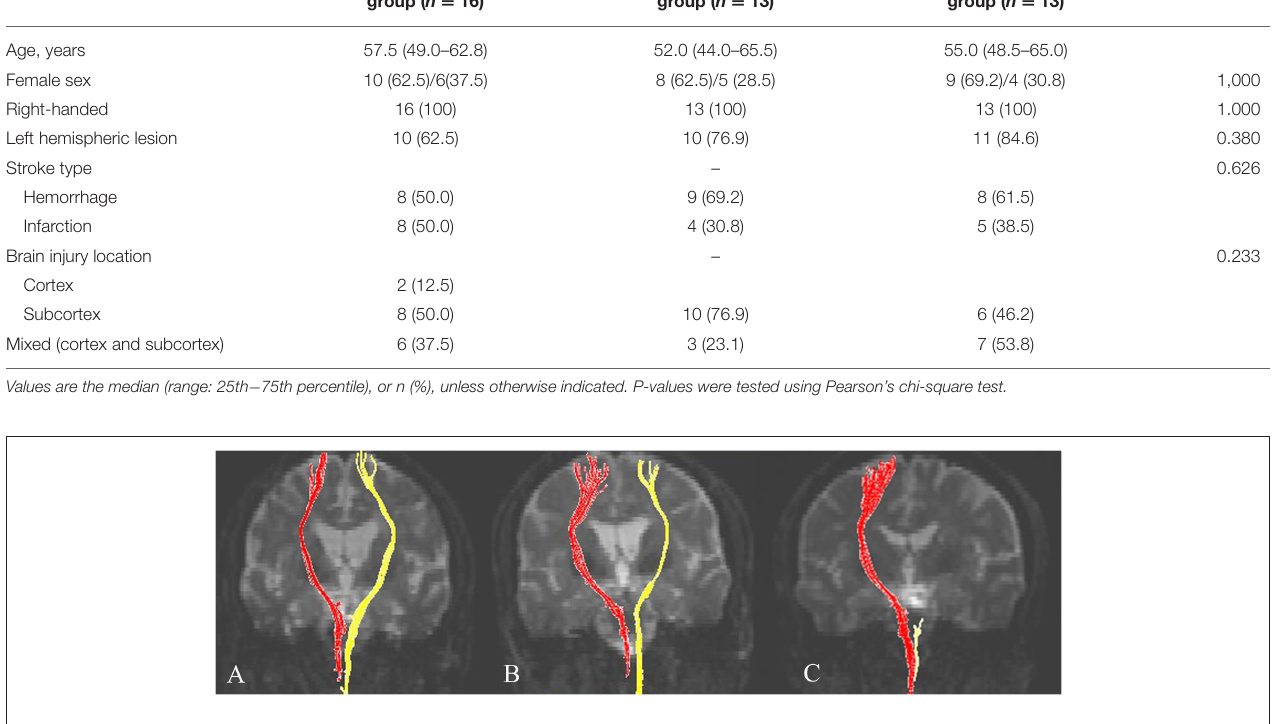
FIGURE 2 | Representative diffusion tensor tractography images of the corticospinal tract in typical subjects from the three groups. Subjects from the (A) full recovery, (B) partial recovery, and (C) no recovery groups. The non-affected tract is shown in red, and the affected tract in yellow.